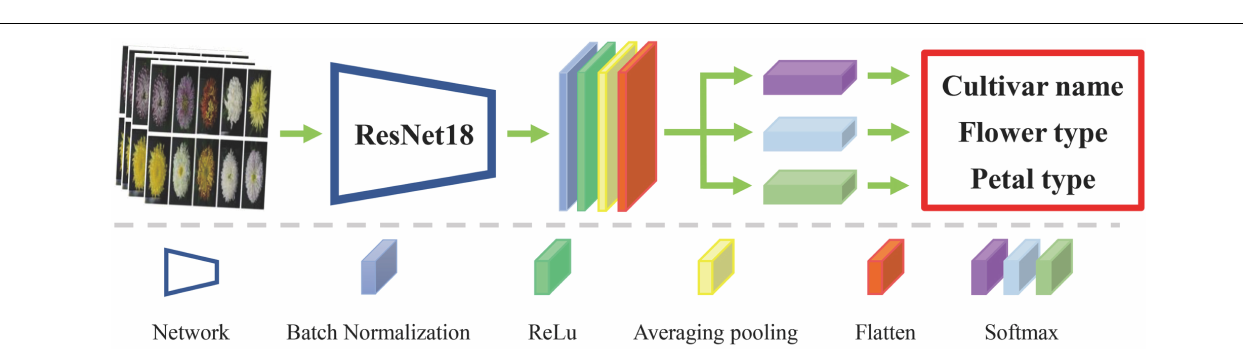
FIGURE 4 | Some sample images in the 2018 and 2019 datasets. Row (A,B) belong to the 2018 and 2019 datasets, respectively.